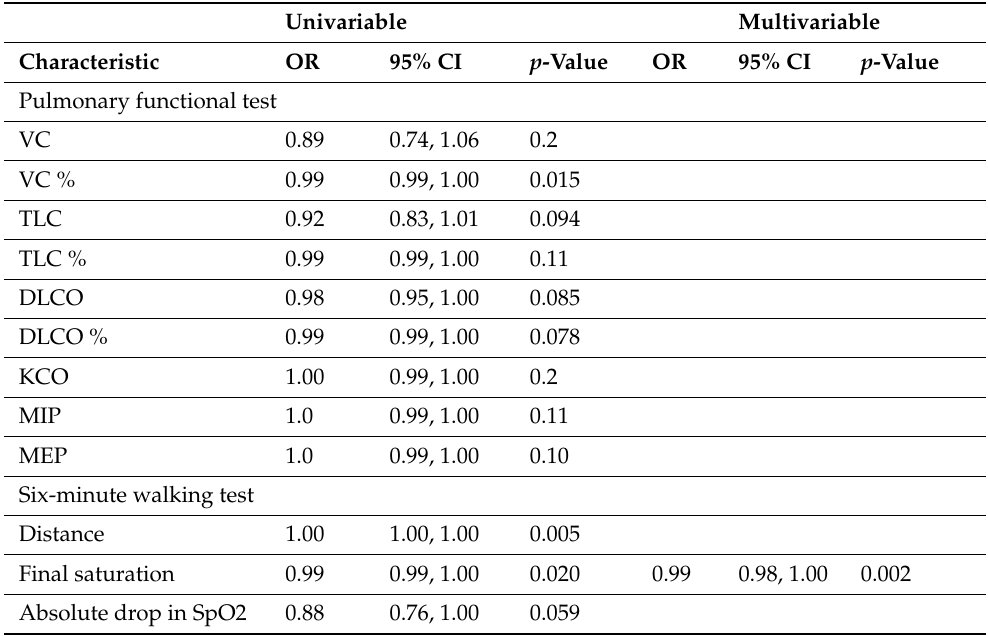
Table 5. Correlation between left ventricular subclinical dysfunction and the multi-parametric evaluations performed at the first